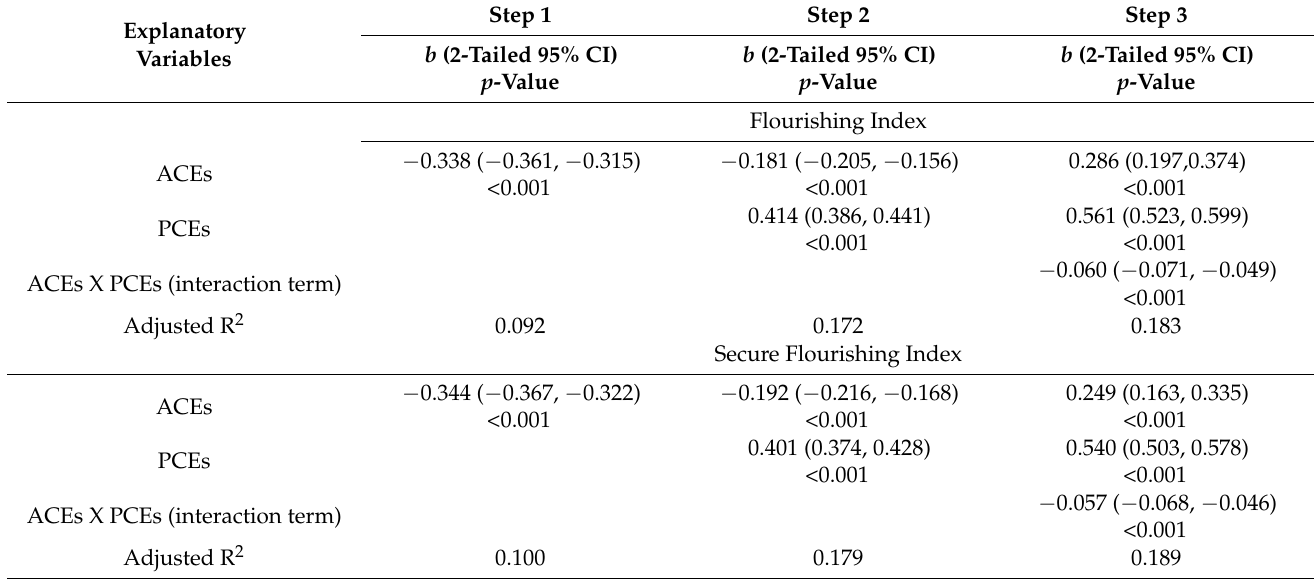
Table 4. Relationships among Flourishing Indices, ACEs, and